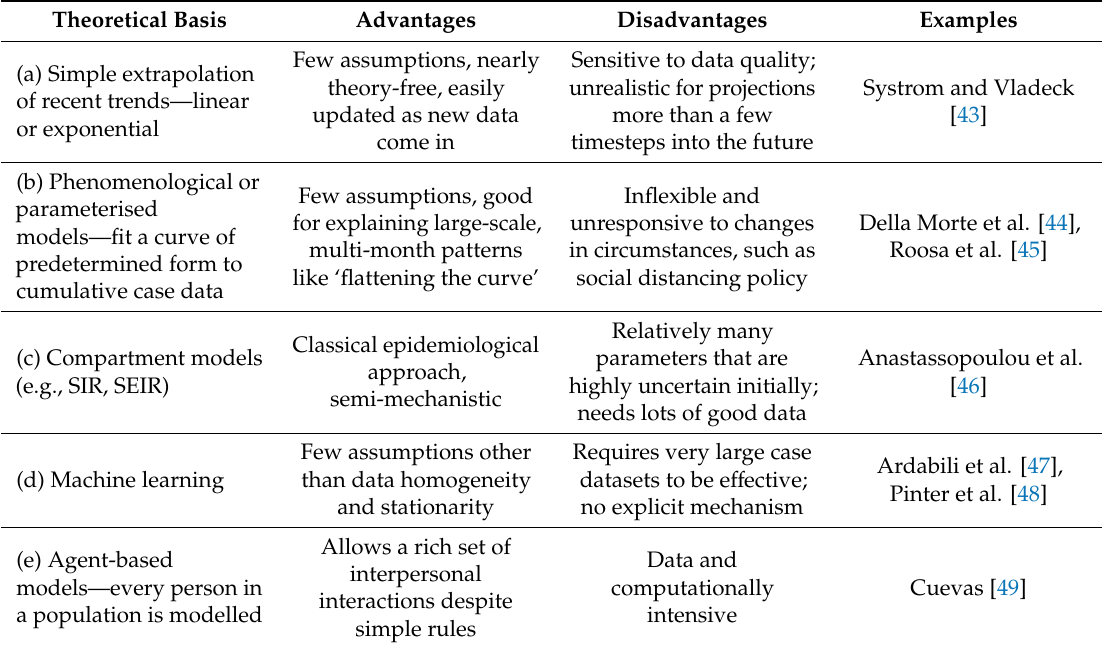
Table 1. A summary of modelling approaches applied to